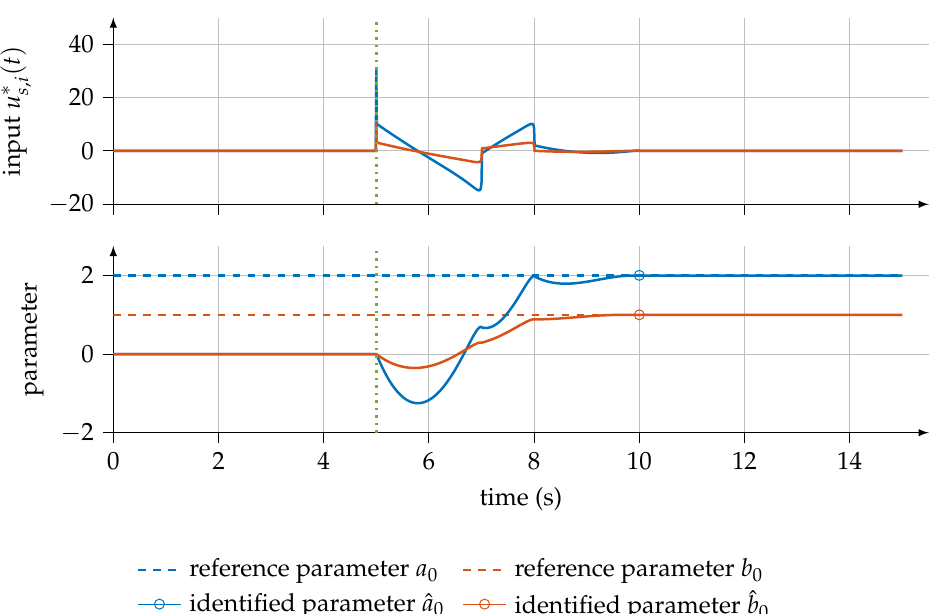
Figure 2. Parameter-specific control input and course of unknown parameter in the noise-free case.